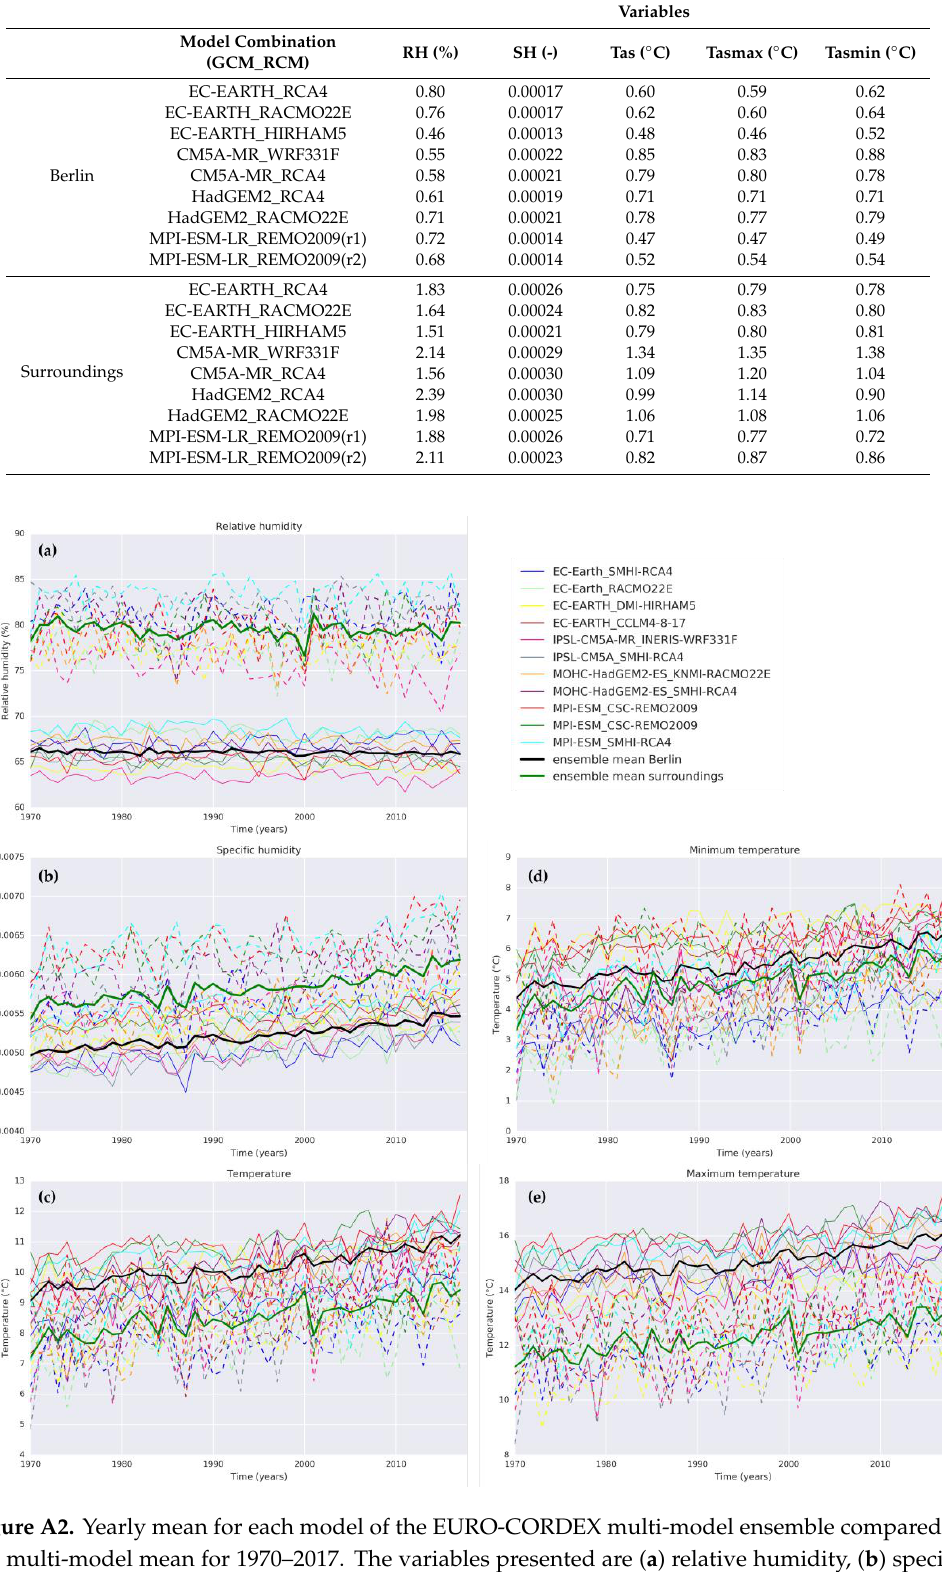
Table A3. Standard deviation for each model combination and for the investigated variables calculated over the annual mean for the period 1970–2016.